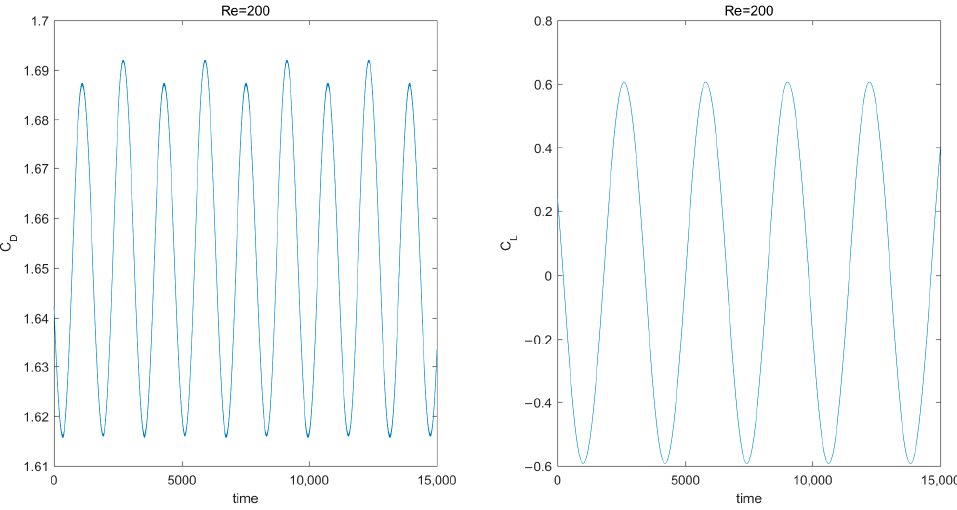
Figure 18. Schematic diagrams of C D and C L periodically changing at Re = 200. Table 3. The parameter settings of averaged drag coefficient C D , lift coefficient C L , and Strouhal numbers St at different Reynolds numbers, compared with those in the other literature.